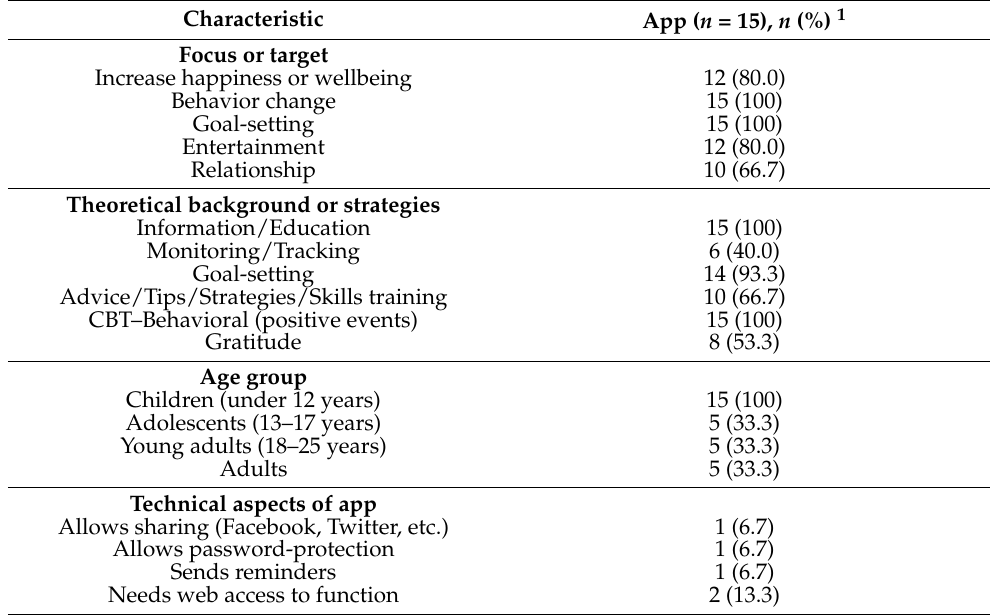
Table 1. Description of the twenty oral hygiene-related mobile applications for children.